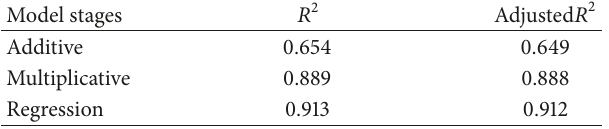
Table 17: Modeling accuracy of each stage.